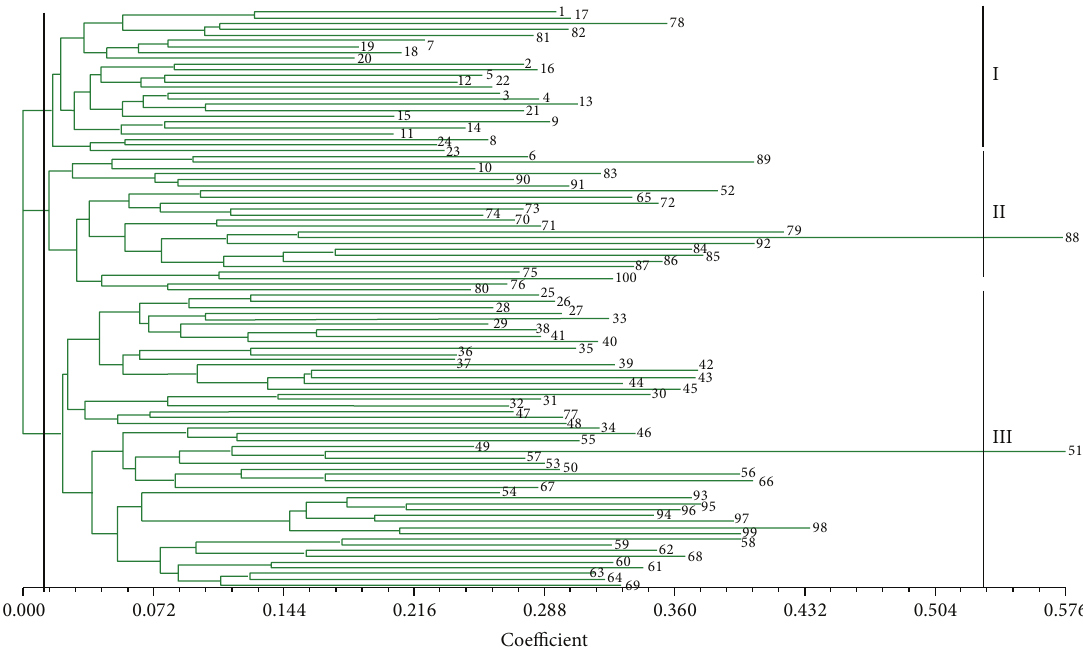
Figure 4: Dendrogram of the 100 S. scitamineum isolates (numbers 1–100) generated by UPGMA based on SP-SRAP data.